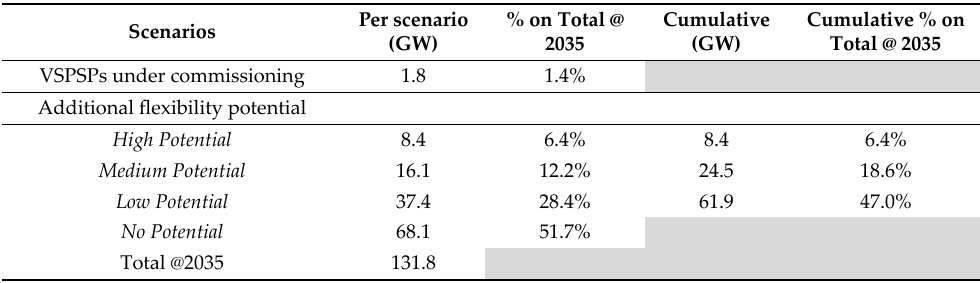
Table 5. Summary of flexibility potentials of PHS in China until 2035. Here, the Maximum Head limit below 600 m is not considered a constraint. Capacity of every single scenario and cumulative capacity with increasing implementation challenges. VSPS under